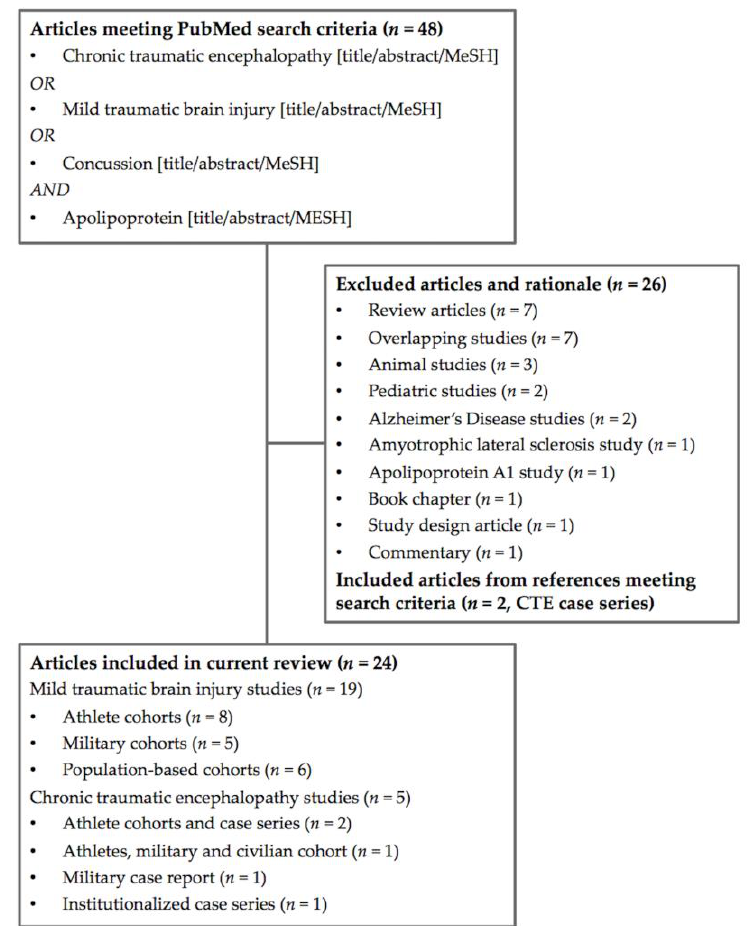
Figure 2. Flowchart of included studies.